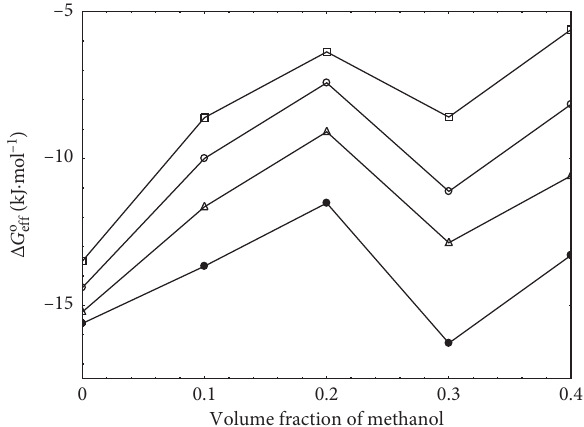
Figure 10: Variation in Δ G o with the volume fraction of meth- eff anol: squares (298.15K), circles (308.15K), triangles (318.15K), and closed circles